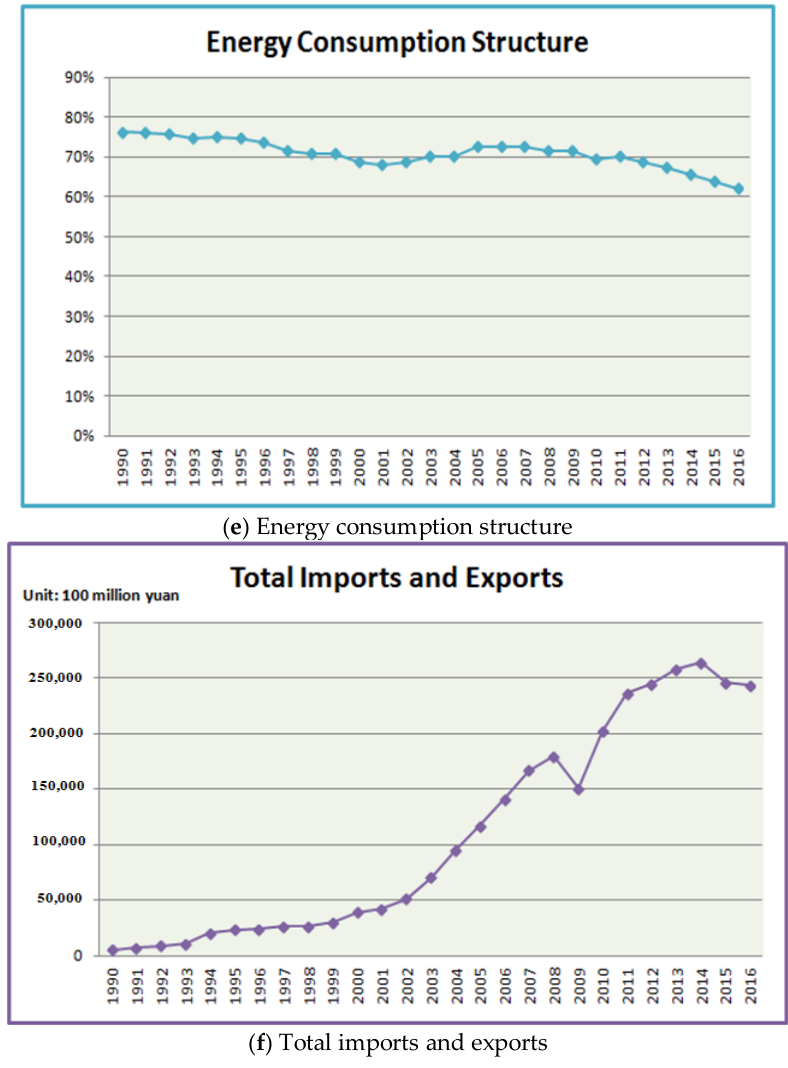
Figure 4. The sample data.